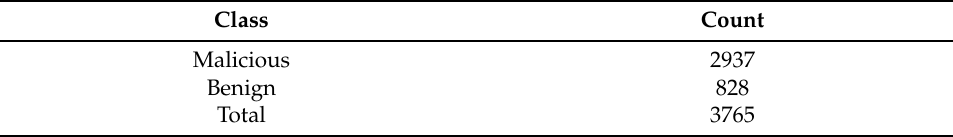
Figure 3. Dynamic analysis output. Table 3. Composition of the dataset after dynamic analysis.